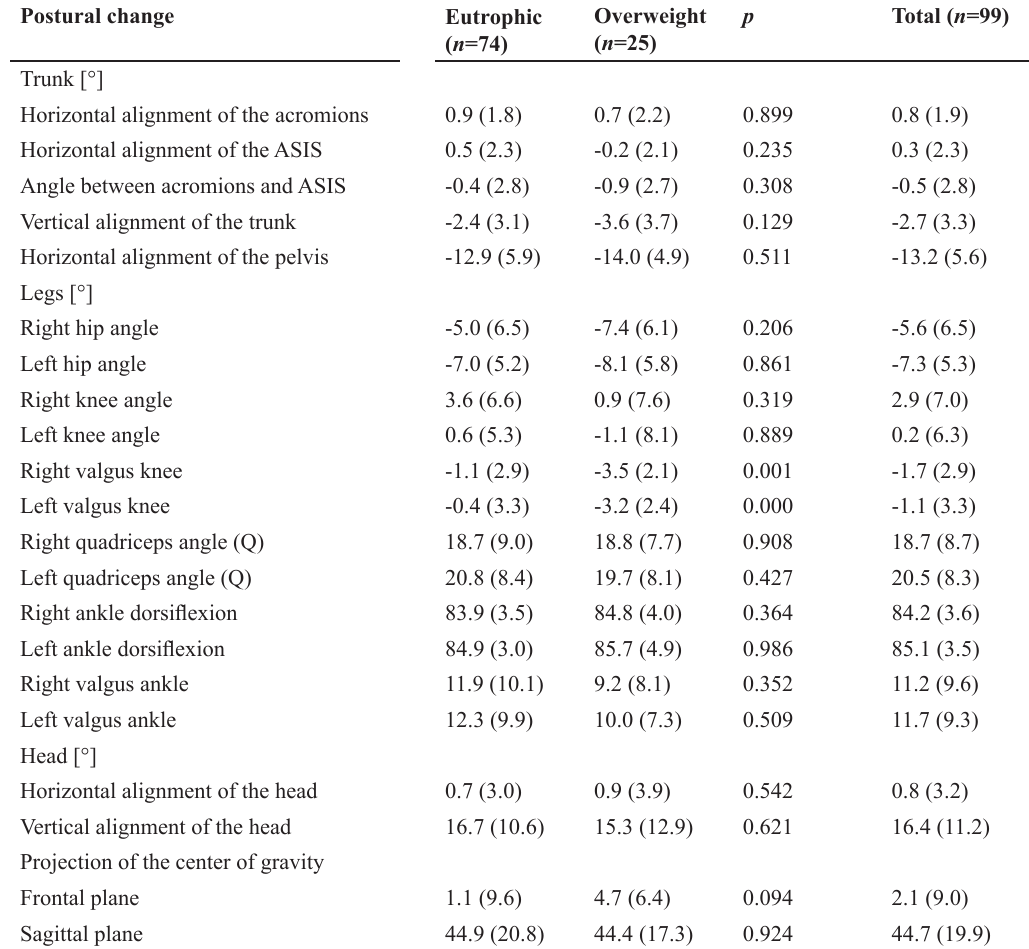
3. Results in degrees of quantitative postural evaluation of the trunk, legs, head and projection of the center of gravity for the different groups [mean